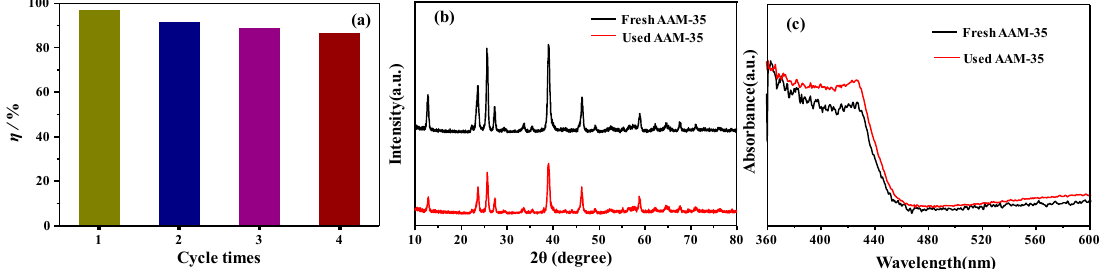
Figure 7. The comparison of ( a ) the degradation ratio of thiophene, ( b ) the XRD patterns and ( c ) diffuse reflectance spectroscopy (DRS) patterns before and after four run times for catalyst AAM-35.